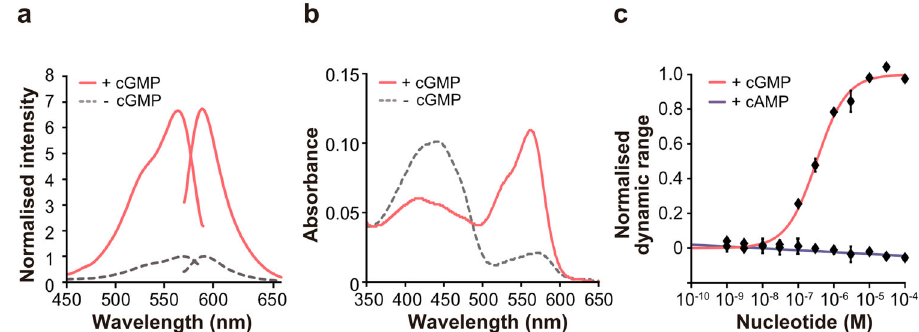
Fig. 2 Spectral properties of Red cGull. a The excitation and emission spectra of 5 μ M Red cGull in the presence (solid line) and absence (dashed line) of 10 μ M of cGMP. The FI was normalised to the maximum FI in the absence of cGMP. b The absorption spectra of 20 μ M Red cGull in the presence (solid line) and absence (dashed line) of 100 μ M of cGMP. The absorption peak of Red cGull decreased to near 450 nm and increased near 570 nm in the presence of cGMP. c Dose-response curve of 1 μ M Red cGull to cGMP (pink line) and cAMP (purple line). Data were shown as means ± standard deviation ( n = 3). FI was normalised to the upper and lower asymptotes. The EC 50 value was calculated from the four-parameter logistic curve as 0.33 μ M. Table 1 Quantum yields and extinction coef fi cients of Red cGull and Red cGull nega.